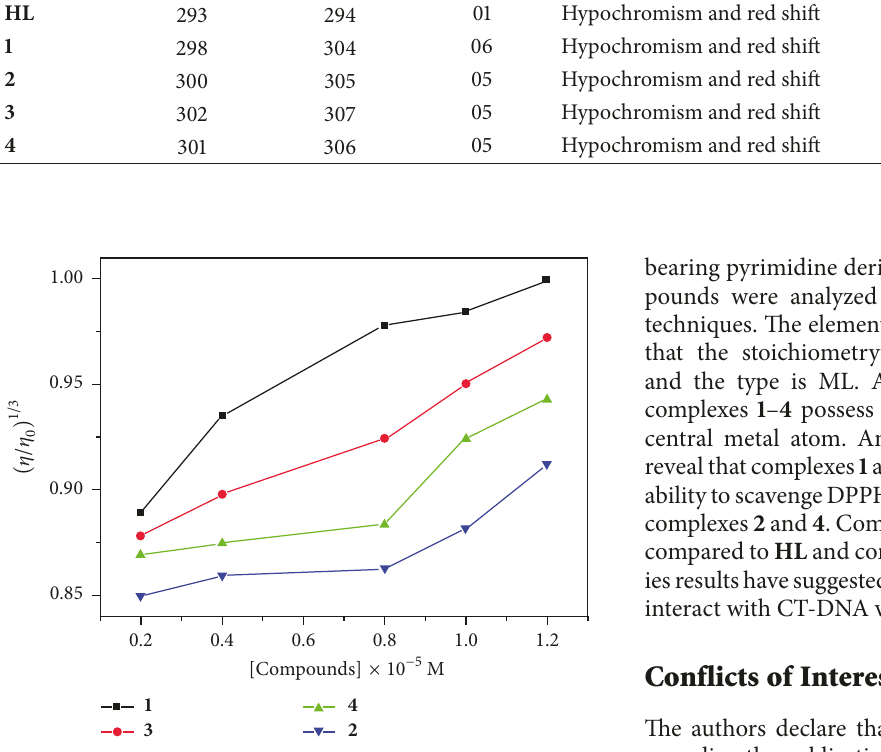
Figure 8: Effect ofincreasing concentration of complexes 1 – 4 on the relative viscosity of